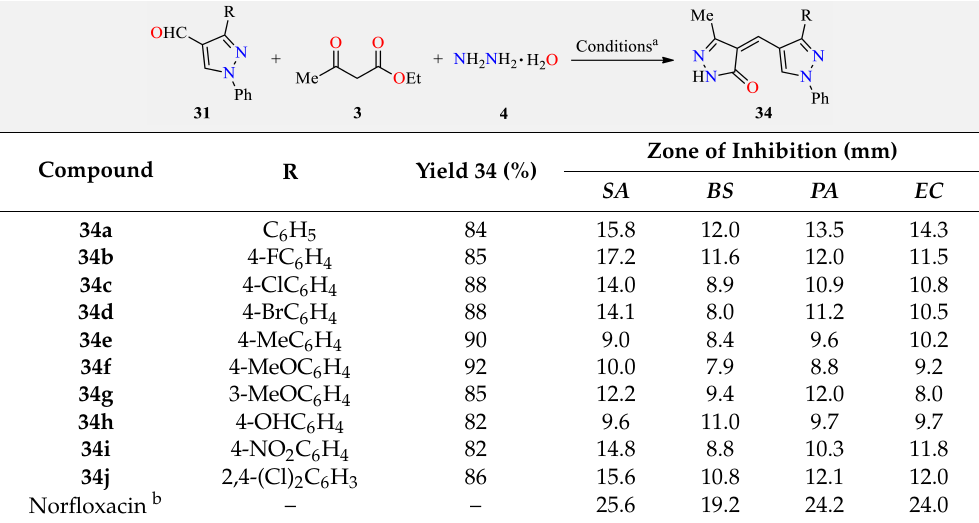
Table 7. One-pot three-component synthesis and antibacterial activity of 4-[(3-aryl-1-phenyl-1 H